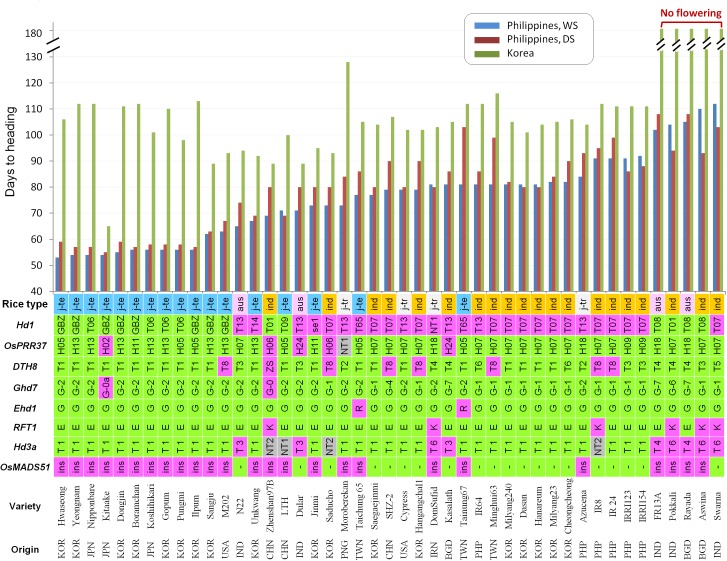
Days to heading (DTH) and the allele types of the major seven heading date genes from 45 diverse accessions. DTH was observed in the three different environments and the samples were sorted by DTH from early to late heading at the IRRI field in the wet season. In the cases of the Ehd1 and RFT1, the FNPs are presented with the corresponding amino acid (G221R of Ehd1 and E105K of RFT1). The tolerance allele to high temperature-induced flowering caused by 9.5-kb insertion at 1st intron of OsMADS51 is presented by ‘ins.’ The allele types with their functionality to each gene are depicted (green: functional allele and pink: non-functional allele). In the case of the Hd3a promoter, Group A and Group B are colored with green and pink, respectively, according to the previous research (Takahashi et al., 2009). New allele types (NT) with unknown functionality are shown with gray color. j-te, temperate japonica; j-tr, tropical japonica; ind, indica.